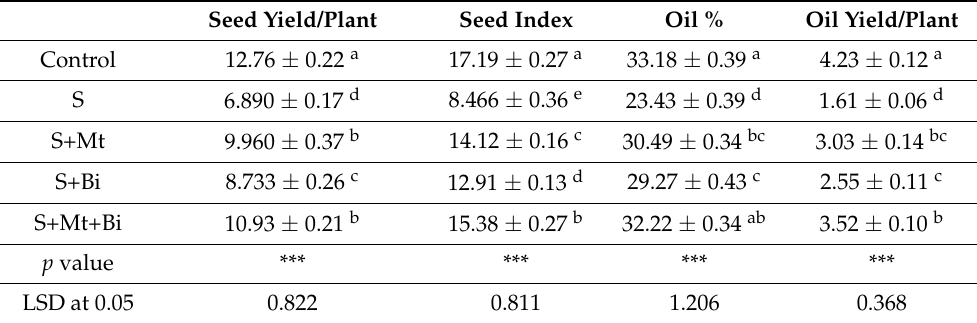
Table 6. The effect of melatonin (Mt) and/or biochar (Bi) supply on seed and oil yield of borage plants grown in a saline medium (S, 5000 ppm NaCl).